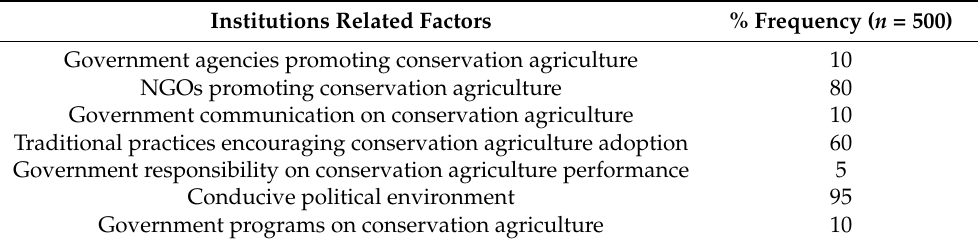
Table 6. Description of the distribution of the answers related to institutions regarding conservation agriculture